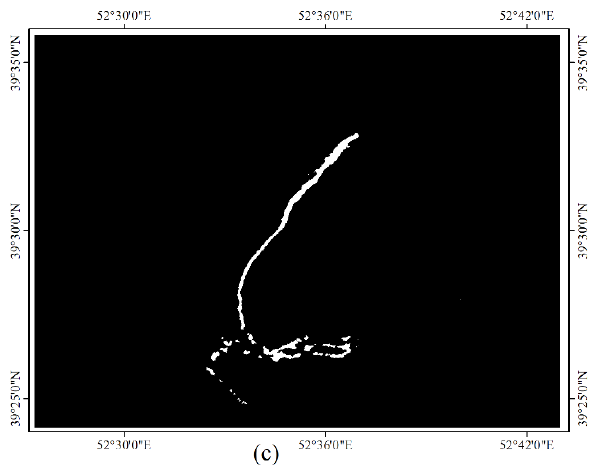
Figure 6 . The outputs of CNN-based methods. The (a) common CNN method, (b) proposed DenseNet method and (c) ground truth image. The white pixels show the oil, and the black ones illustrate the